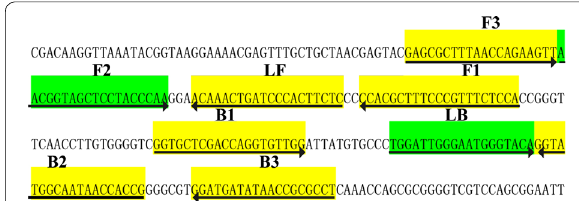
Fig. 1 Primers specific to P1 gene of MP used for LAMP-LFB assay. Locations and sequences of the LAMP-LFB primers specific to MP were displayed. The arrows indicated the direction of the primer from 5 ′ to 3 ′